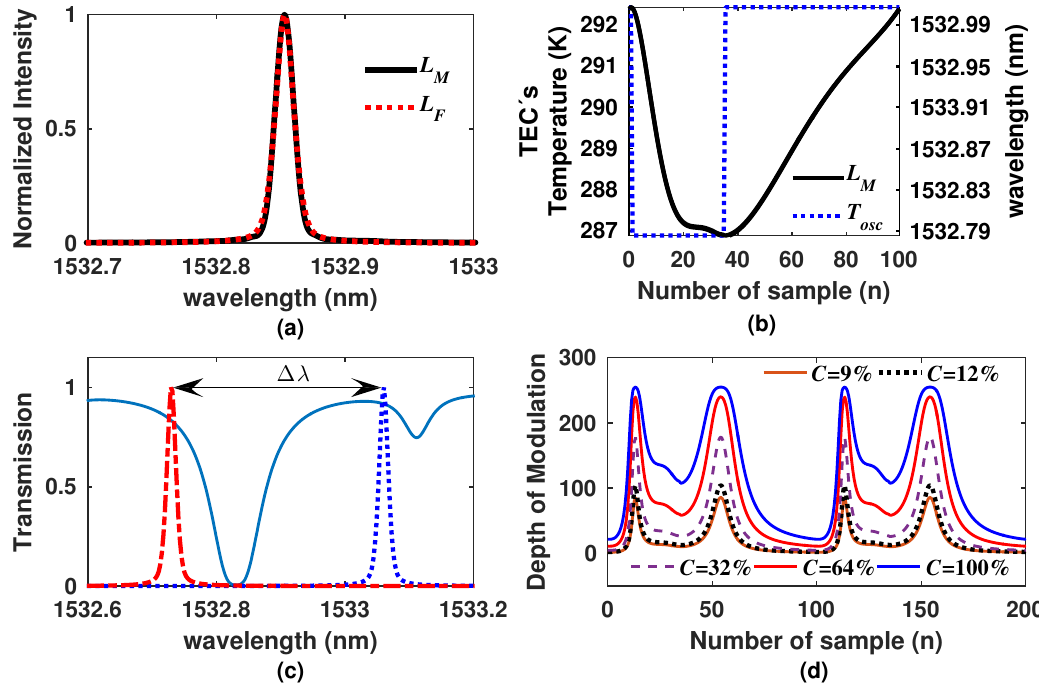
Figure 11. ( a ) Measured and fitted laser line emission; ( b ) laser wavelength as a function of the time as a consequence of the variation of the Si wafer temperature; ( c ) simulated transmission of C 2 H 2 when C = 50% and the initial and final positions of the laser emission tuning range; ( d ) simulated D M waveforms as a function of time for different C 2 H 2